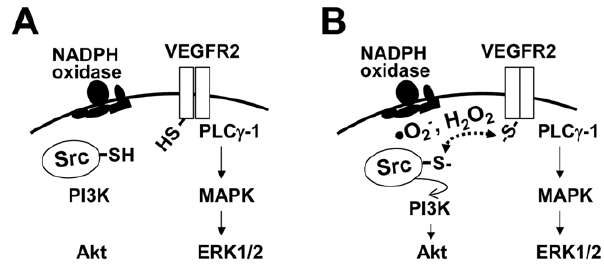
Figure 5. Proposed model: thiol oxidation may help propagate signal transduction from VEGFR-2 to downstream c-Src. (A) VEGF activation of VEGFR-2 and downstream PLC c -1-ERK1/2 signaling pathway appears to be independent of ROS levels in ECs. (B) VEGF induces NADPH oxidase-derived ROS, which in turn oxidizes VEGFR-2 and c-Src. Thiol oxidation of these two tyrosine kinases appears to correlate with VEGF-induced activation of c-Src, and also with the sub- cellular colocalization and interaction between VEGFR-2 and c-Src. Dependence of VEGF-induced thiol oxidation and activation of c-Src on NADPH oxidase-derived ROS render downstream activation of PI3K-Akt redox-sensitive in HCAEC. In this model, VEGFR-2 and/or c-Src act as endothelial redox-sensors that determine whether downstream PI3K- Akt signaling pathway should be activated or not.